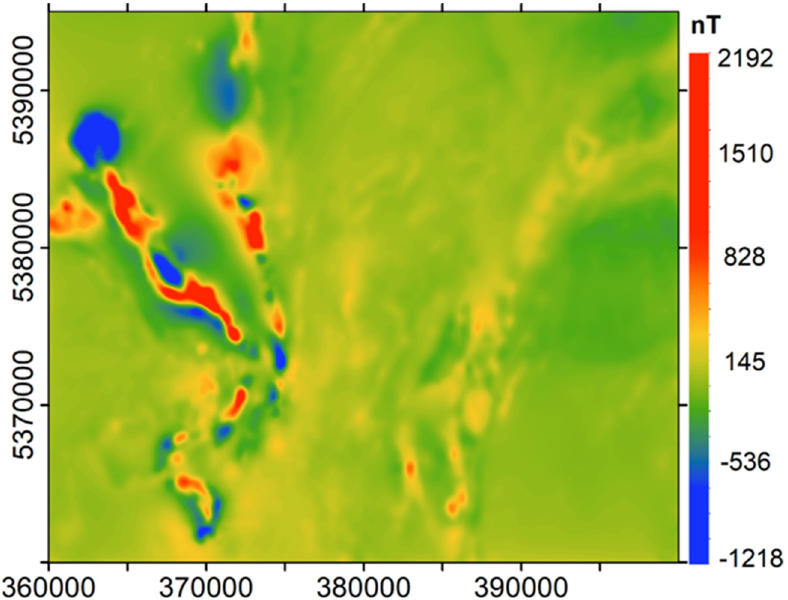
Figure 7. The TMI residual misfit of the Rosebery Region reference model (i.e., the difference between the observed and calculated responses; rms misfit 175.81 nT). Red residual anomalies indicate that additional magnetic material is required to reduce the misfit to match the observed TMI response. In contrast, blue residuals indicate that less magnetic material is required to reduce the